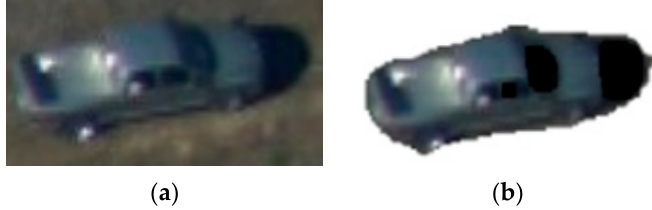
Figure 2. Results of ( a ) bounding-box and ( b ) object-contour recommendation methods.